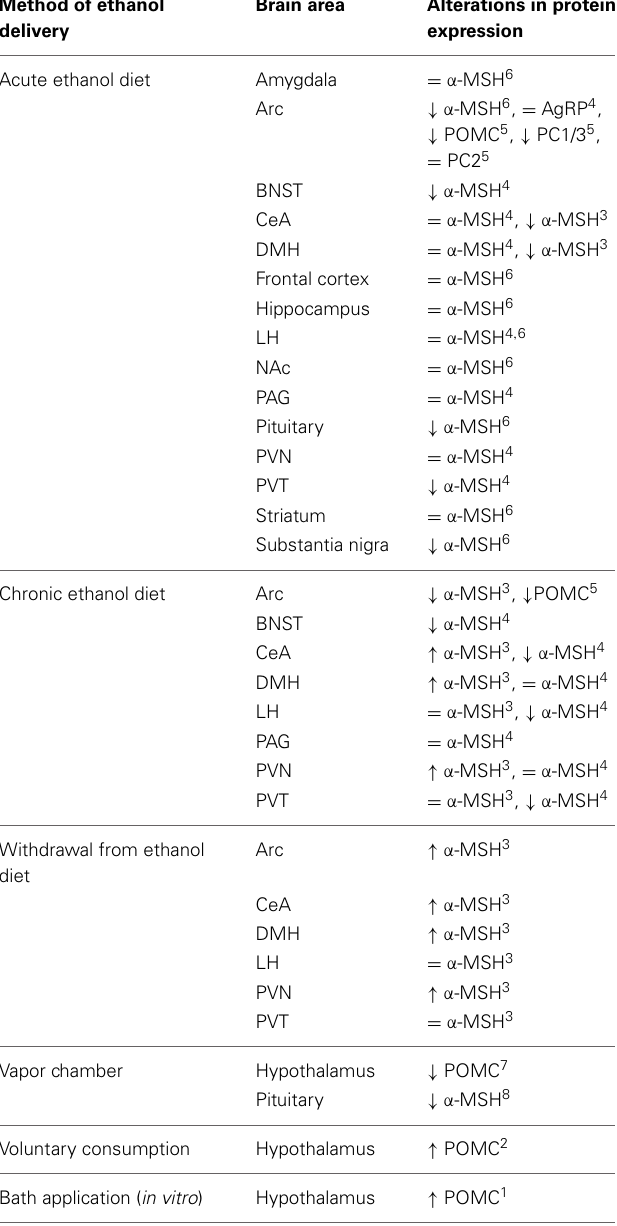
Table 1 | Summary of findings examining the effects of ethanol exposure on the melanocortin